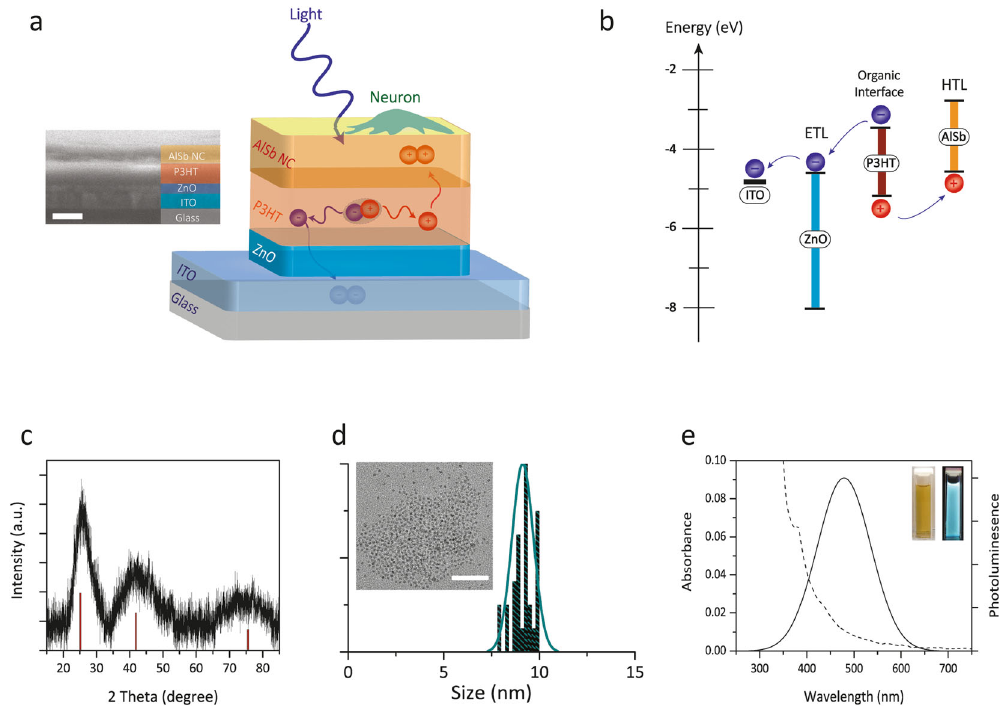
Fig. 1 Biointerface design and operation. a The structure of the photovoltaic biointerface using ITO, ZnO, P3HT, AlSb NCs as substrate, electron transport layer (ETL), donor component and hole transport layer (HTL), respectively. Inset: Cross-sectional scanning electron microscopy (SEM) image of the biointerface (Scale bar: 200 nm). b Energy levels of bulk ZnO 55 , P3HT 17,23 , and AlSb 55 . c XRD pattern of the AlSb NCs. (The vertical lines at the bottom are the corresponding positions and intensities of X-ray re fl ections for the bulk AlSb (PDF 00-006-0233) 24 ). d Particle size distribution of the AlSb NCs (minimum 50 particles were counted). Inset: TEM image of the AlSb NC (Scale bar: 50 nm)). e Absorbance (dashed) and photoluminescence (solid) of the AlSb NCs dispersed in toluene. (Photograph of the AlSb NC solution under ambient (left inset) and UV light (right